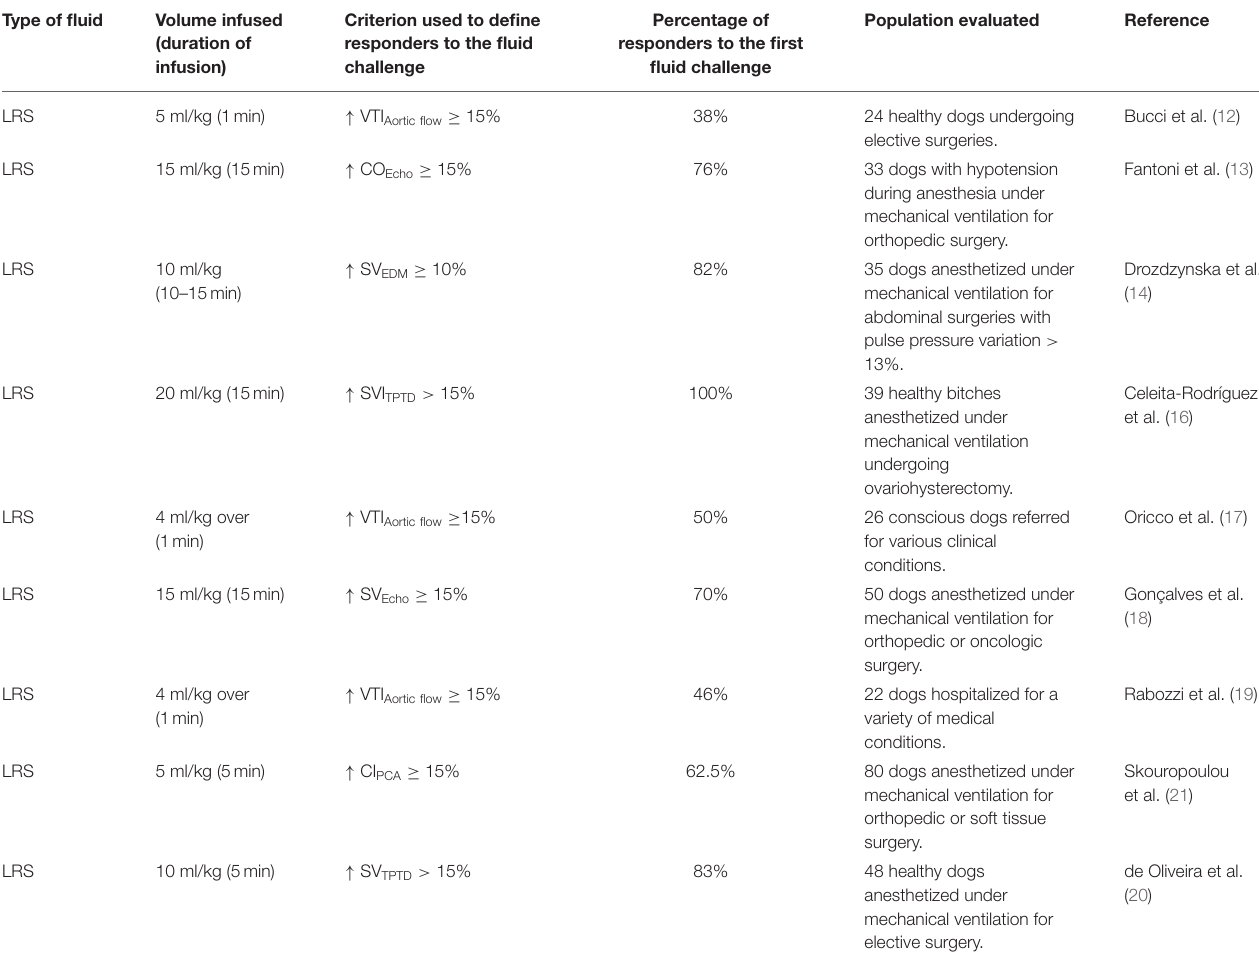
TABLE 2 | Fluid challenge techniques with crystalloids used to evaluate fluid responsiveness in dogs. Type of